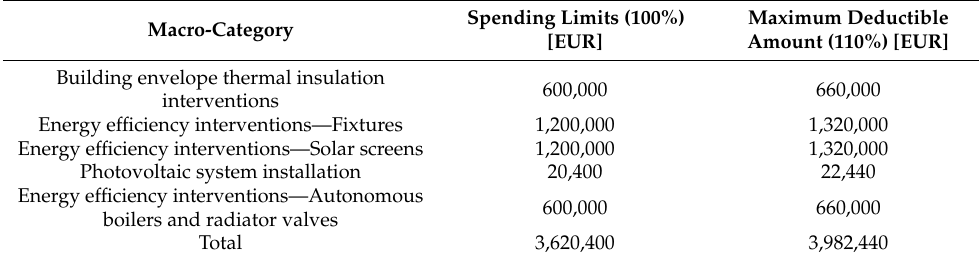
Table 3. Spending limits and maximum deductible amount per processing